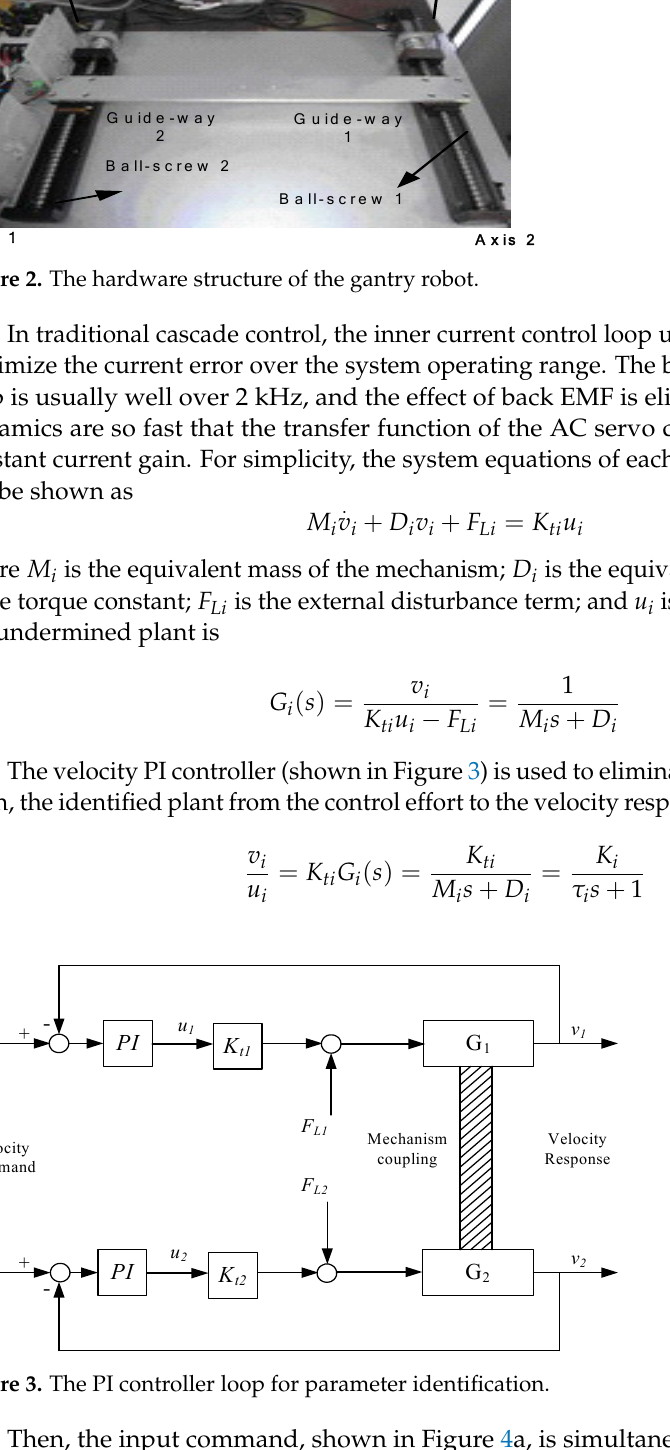
Figure 3. The PI controller loop for parameter identification.